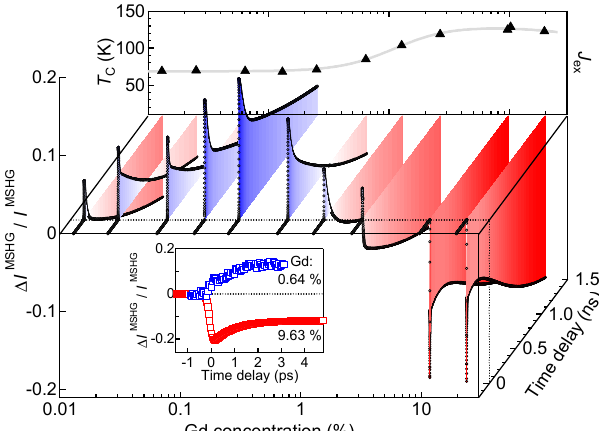
Figure 6. Change of the MSHG intensity at 10 K in Eu 1 − x Gd x O as a function of time delay and Gd concentration (0.013% ≤ x ≤ 19.5%). The excitation density of the pump pulse is ∼ 130 µ J/cm 2 for all traces, which creates a photo-carrier density ∆ n c ∼ 1 × 10 19 cm − 3 . The inset shows a magnified view of the ultrafast increase and decrease of the MSHG intensity for x = 0.64% and x = 9.63% .